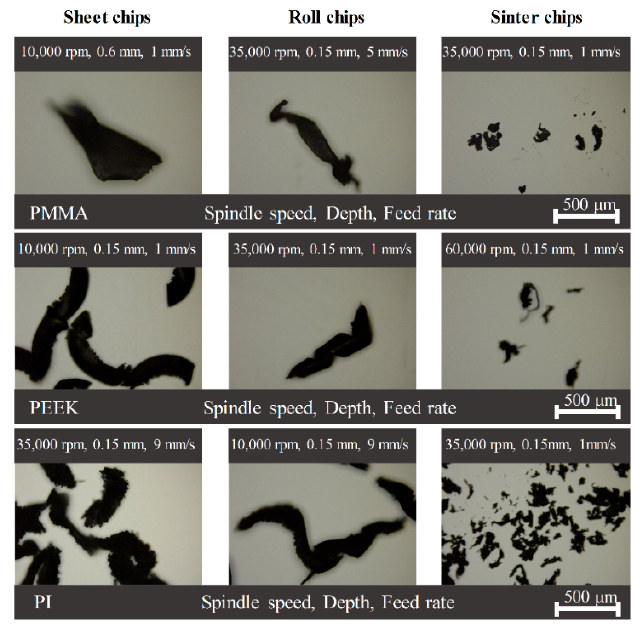
Figure 9. Characteristics of cutting chips for PMMA, PEEK, and PI.